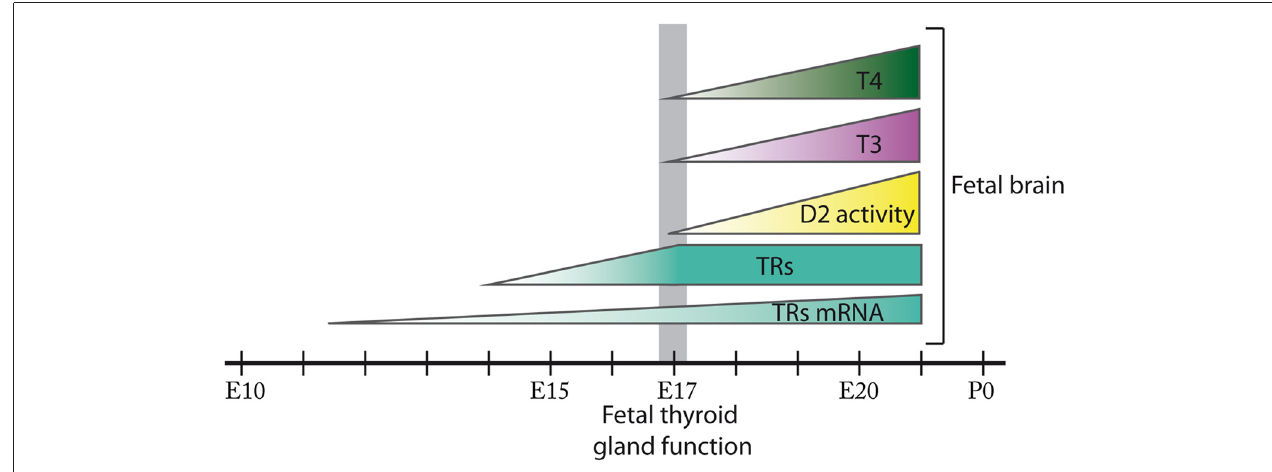
FIGURE 1 | Ontogenesis of thyroid hormone action during fetal brain development in the rat. In the rat brain, thyroid hormone receptors (TRs) mRNA expression is detected from E11.5 and TRs from E14. D2 activity in addition to 3,5,3 (cid:48) ,5 (cid:48) -tetraiodo-L-thyronine (T4) and 3,5,3 (cid:48) -triodo-L-thyronine (T3) content are present in the rat fetal brain from at least E17 when the onset of fetal thyroid function takes place. D2 activity, T4 and T3 content progressively increase in the rat fetal brain from E17 until E21. The size of the figures does not represent relative abundance. Most of these events remain to be fully elucidated in the